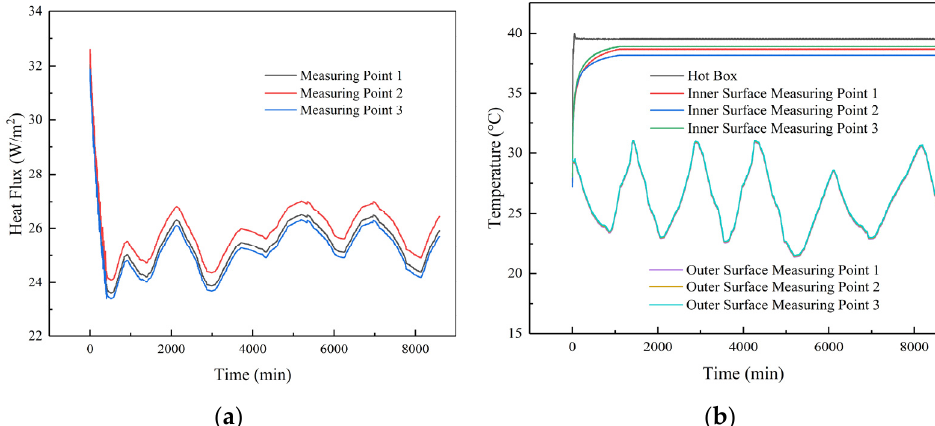
Figure 10. B-490 test data: ( a ) heat flux; ( b ) temperature.